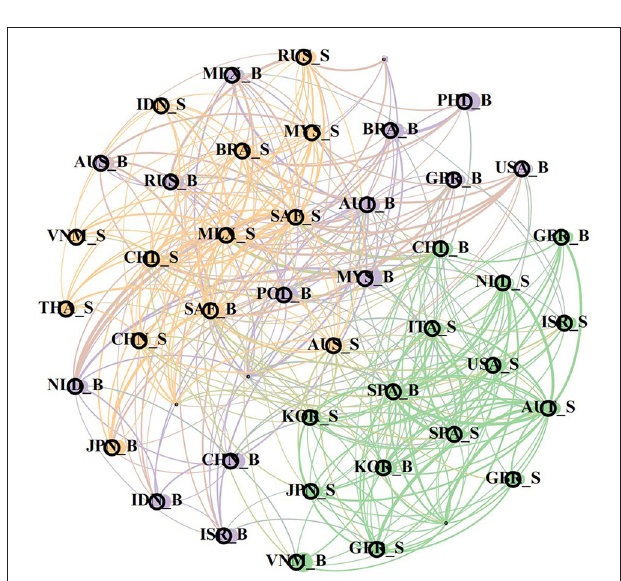
FIGURE 3 | Bank-sovereign risk network in short-term.